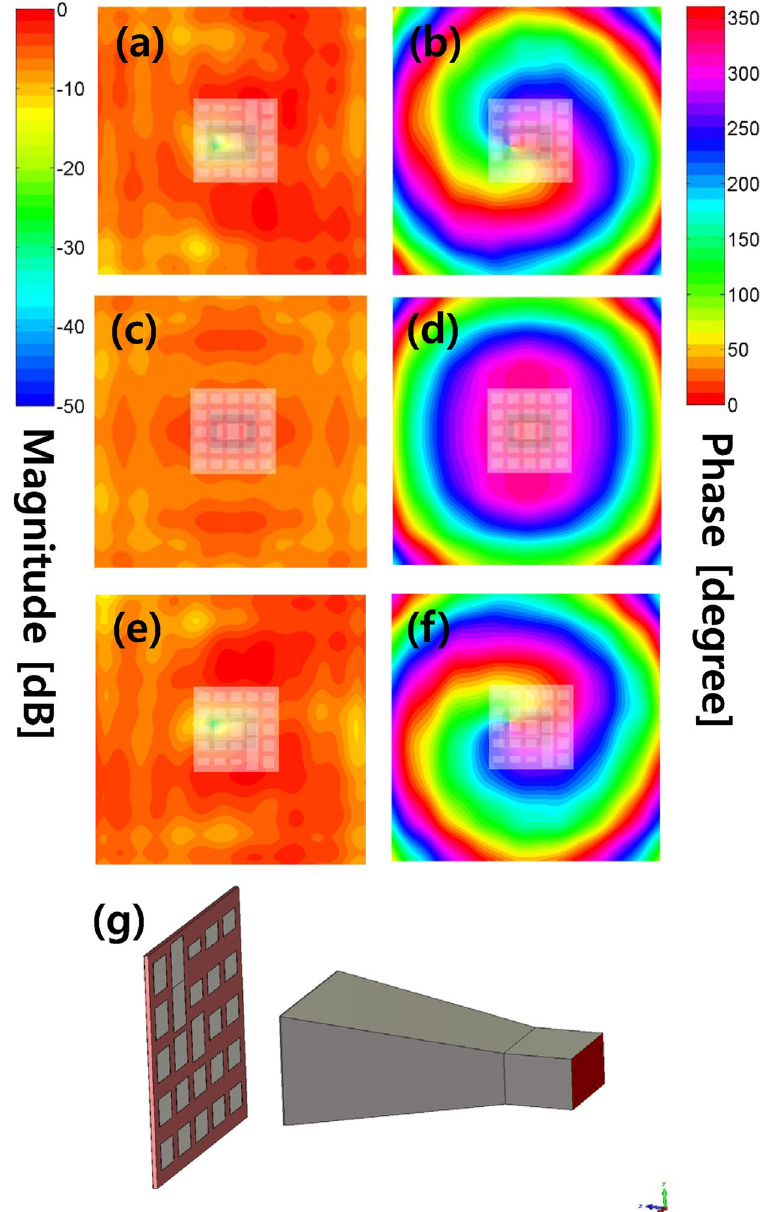
Figure 4. Simulated near-field magnitude and phase patterns using f = 18 [GHz] and z = − 100 [mm] for the Cassegrain dual-reflectarray antenna without the main reflectarray shown in Fig. 1. The edges of the horn aperture and sub-reflectarray are placed at z = 23.6 and 44.4 [mm], respectively. The sub-reflectarrays are overlaid with the near-field patterns to clarify helical phase centers of the given OAM mode numbers, where a helical phase center means a point satisfying the minimum magnitude in term of helical phase. We observe that = ± . (a,c,e) Simulated the corresponding x y ( , ) positions of the helical phase centers vary according to l 1 sub = + − , respectively. (b,d,f) Simulated phase patterns for l 1, 0, 1 = + − , magnitude patterns for l 1, 0, 1 sub sub respectively. (g) Example of a simulation setup for = + l 1 sub